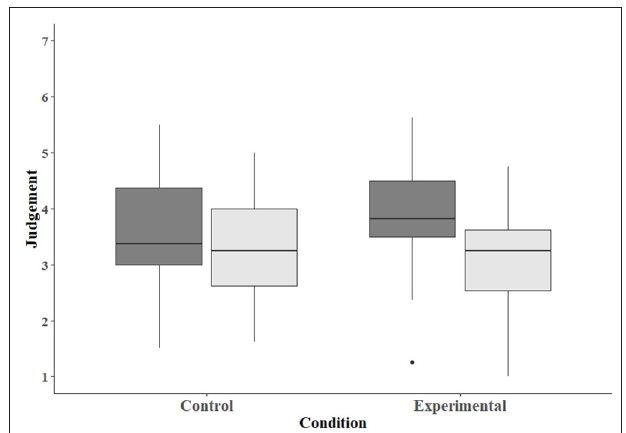
FIGURE 1 | Box plot depicting the scores assessing tendencies of participants in the control and experimental conditions to judge clients. Dark-gray bars represent scores on the pretest, and light-gray bars scores on the